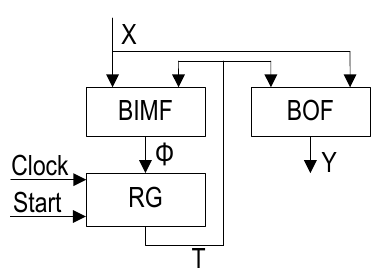
Figure 1. Structural diagram of Mealy FSM U 1 .